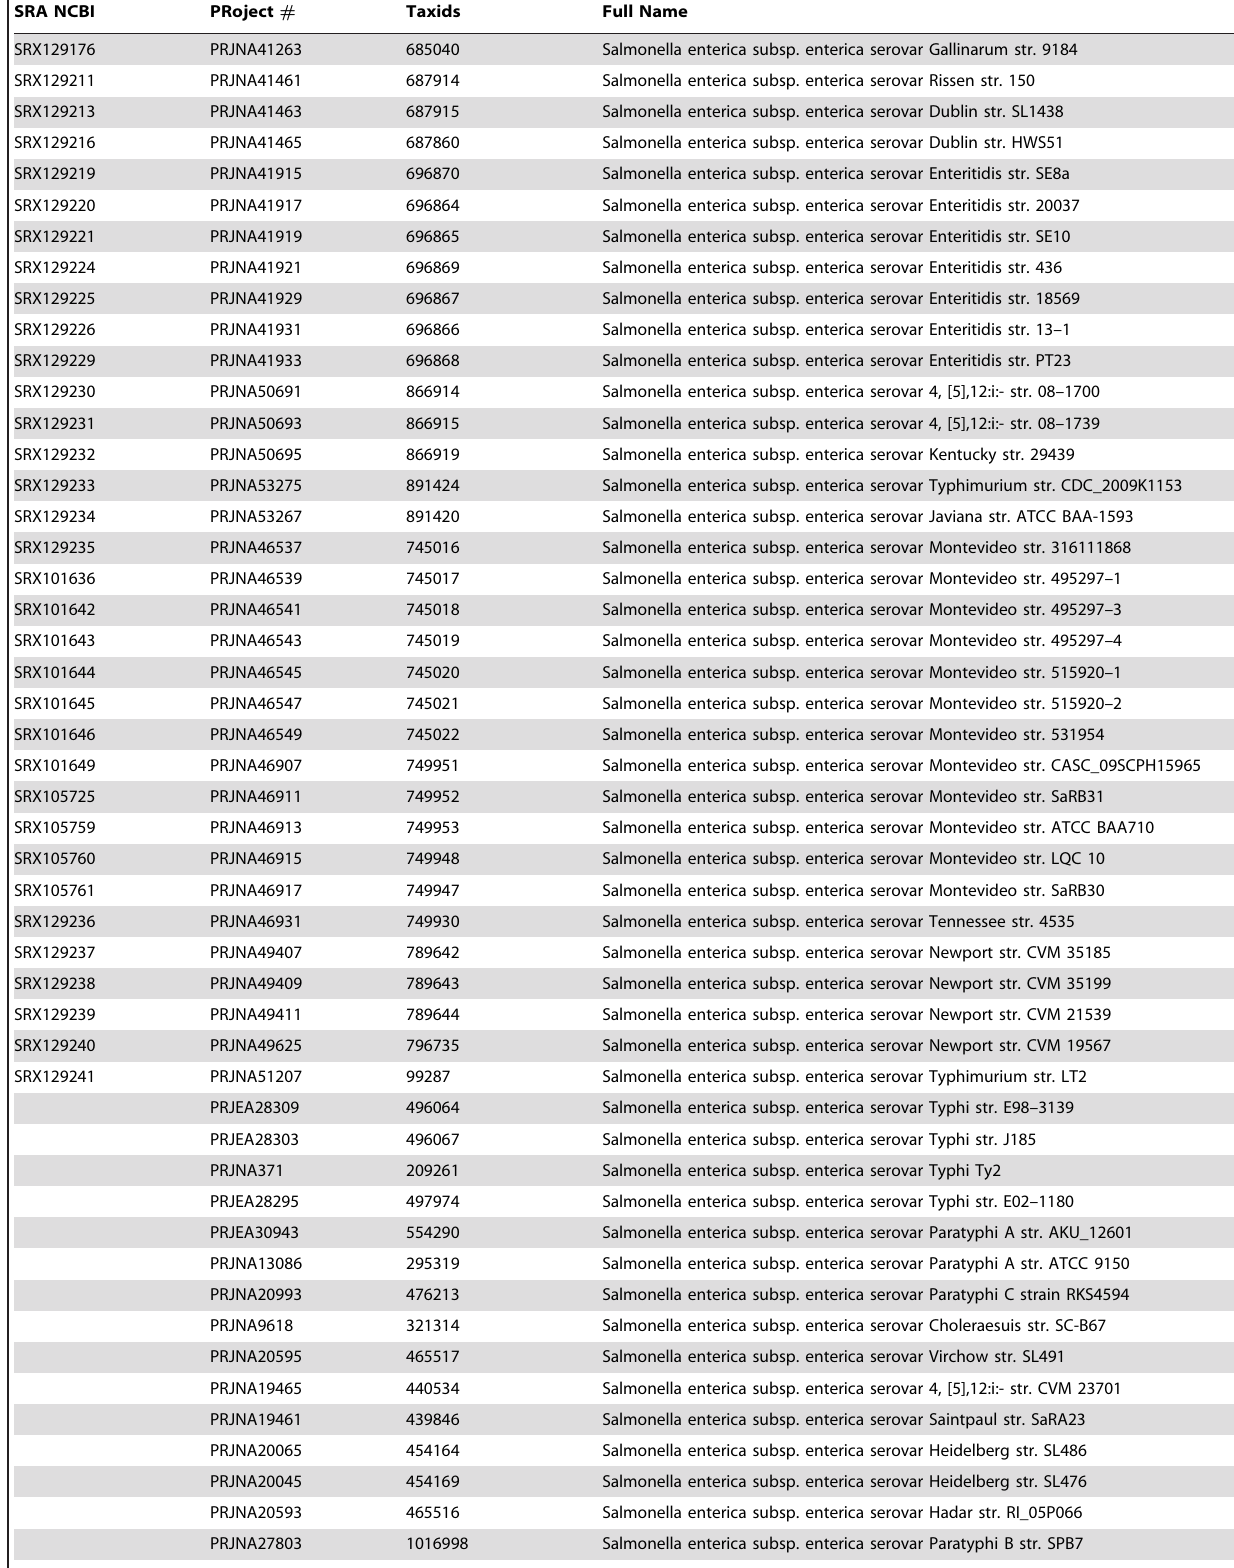
Table 1. Genome sequences used in this